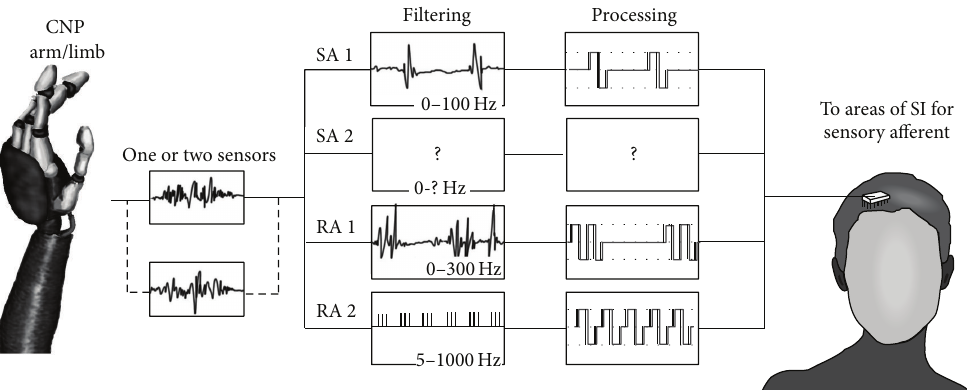
Figure 4: A schematic demonstrating possible filter designs and subsequent processing that could be used to replicate signals from native sensory afferents [13]. The proposed filters for band selection and processing are derived from the properties of sensory afferents from Table 1. SA I signals are shown being replicated by low-pass filtering to 100Hz; then processing would be applied to replicate as close to 5 Hz steps of sensitivity applicable. RA I shows filtering followed by processing to replicate rapid adaptation as well as the sensitivity levels. RA II signals are shown being replicated by a hypothetical wavelet transform, showing the coefficients for a particular frequency range represented by a wavelet at a particular resolution. Since not much is known about the particular frequency range of SA II signals, it is listed blank. All filter designs and processing methods shown in the figure are